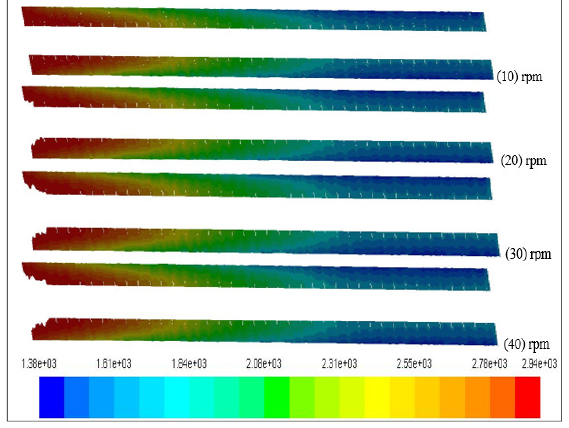
Fig. 9. Temperature Contour plane at 500